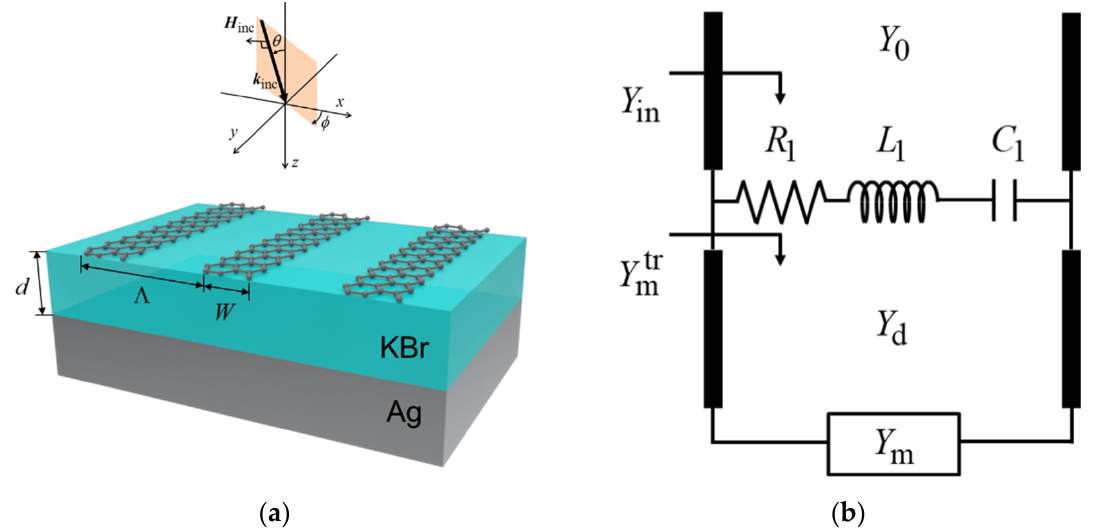
Figure 1. ( a ) Schematic of graphene ribbon metasurface. This structure consists of Ag substrate, KBr layer, and graphene ribbon layer. The period is Λ [µm], graphene ribbon width is W [µm], and dielectric thickness is d [µm]. Transverse magnetic wave is used as the incident wave. ( b ) Equivalent circuit model based on graphene plasmon.